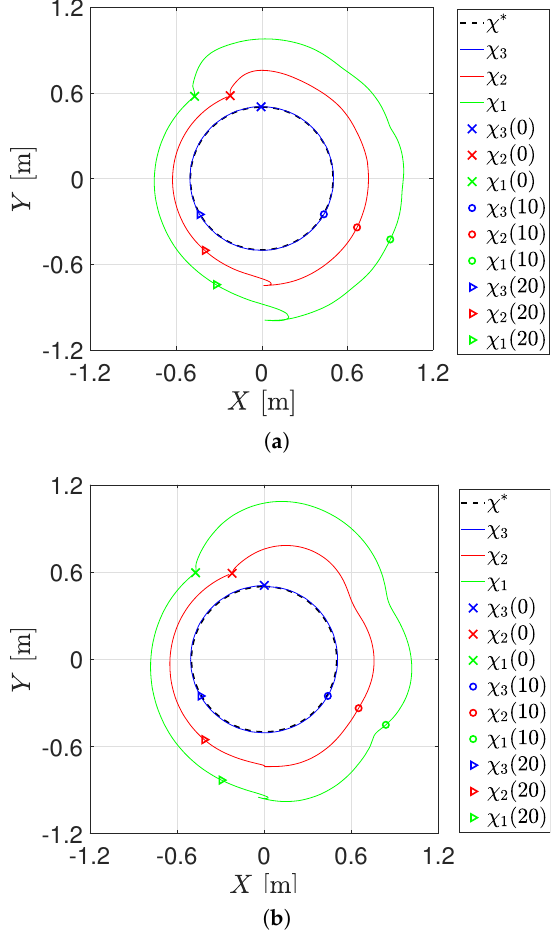
Figure 4. Trajectory in the plane of the mobile robots for the first experiment. ( a ) Trajectory in the plane with the GPIO approach. ( b ) Trajectory in the plane with the PI approach.